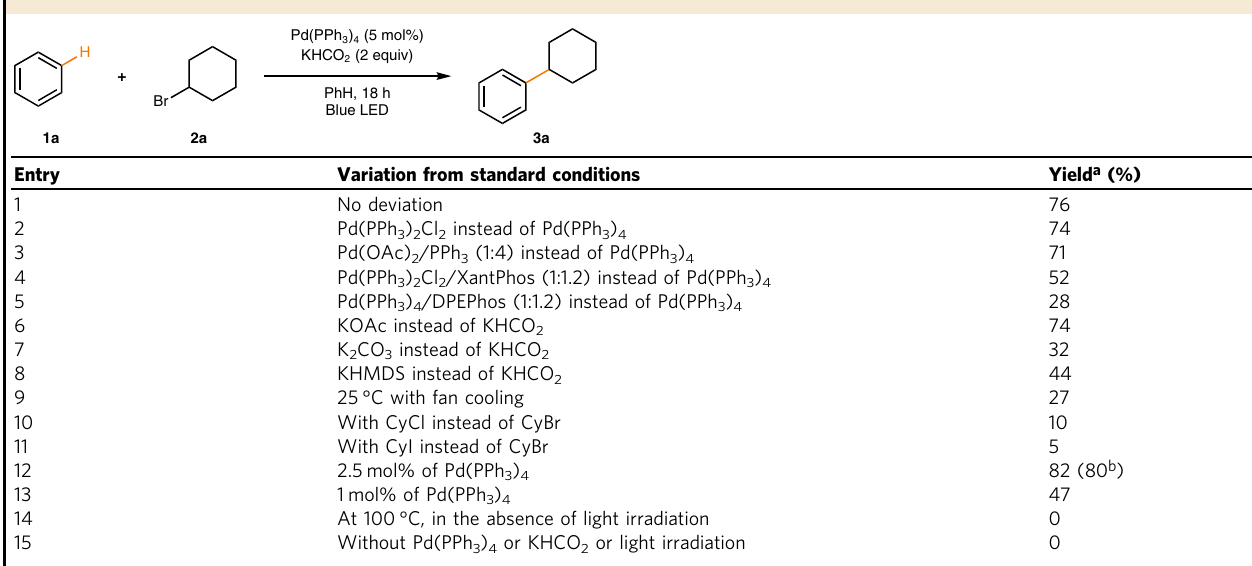
Table 1 Optimization of the Pd-catalyzed C(sp 2 ) – H alkylation of